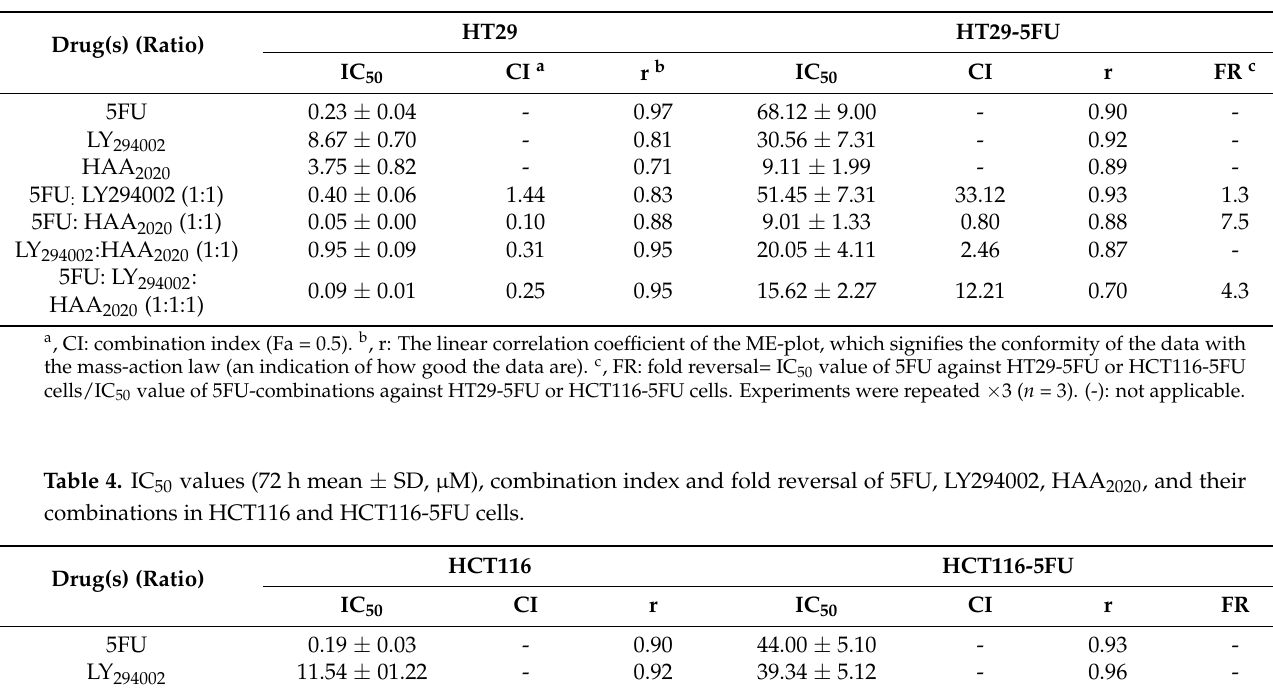
Table 3. IC 50 values (72 h mean ± SD, µ M), combination index and fold reversal of 5FU, LY294002, HAA 2020 , and their combinations in HT29 and HT29-5FU cells.